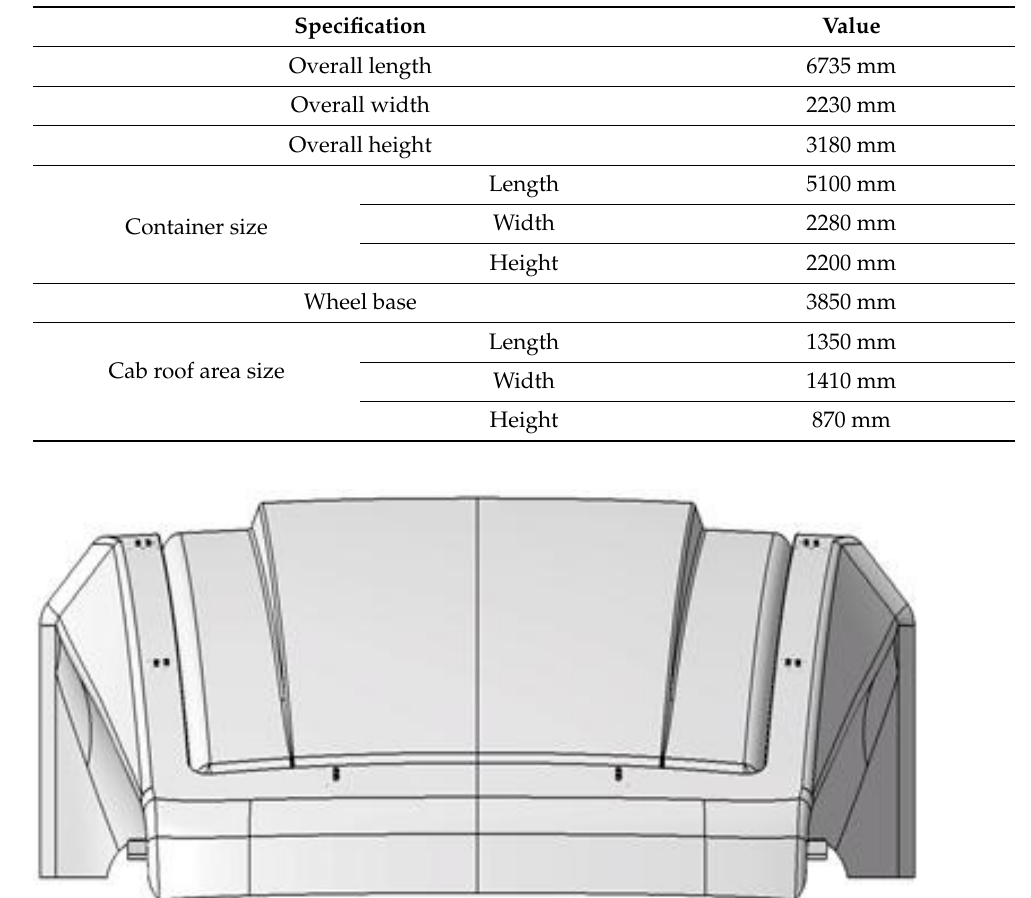
Figure 1. 3D view of conceptual aerodynamic configuration.